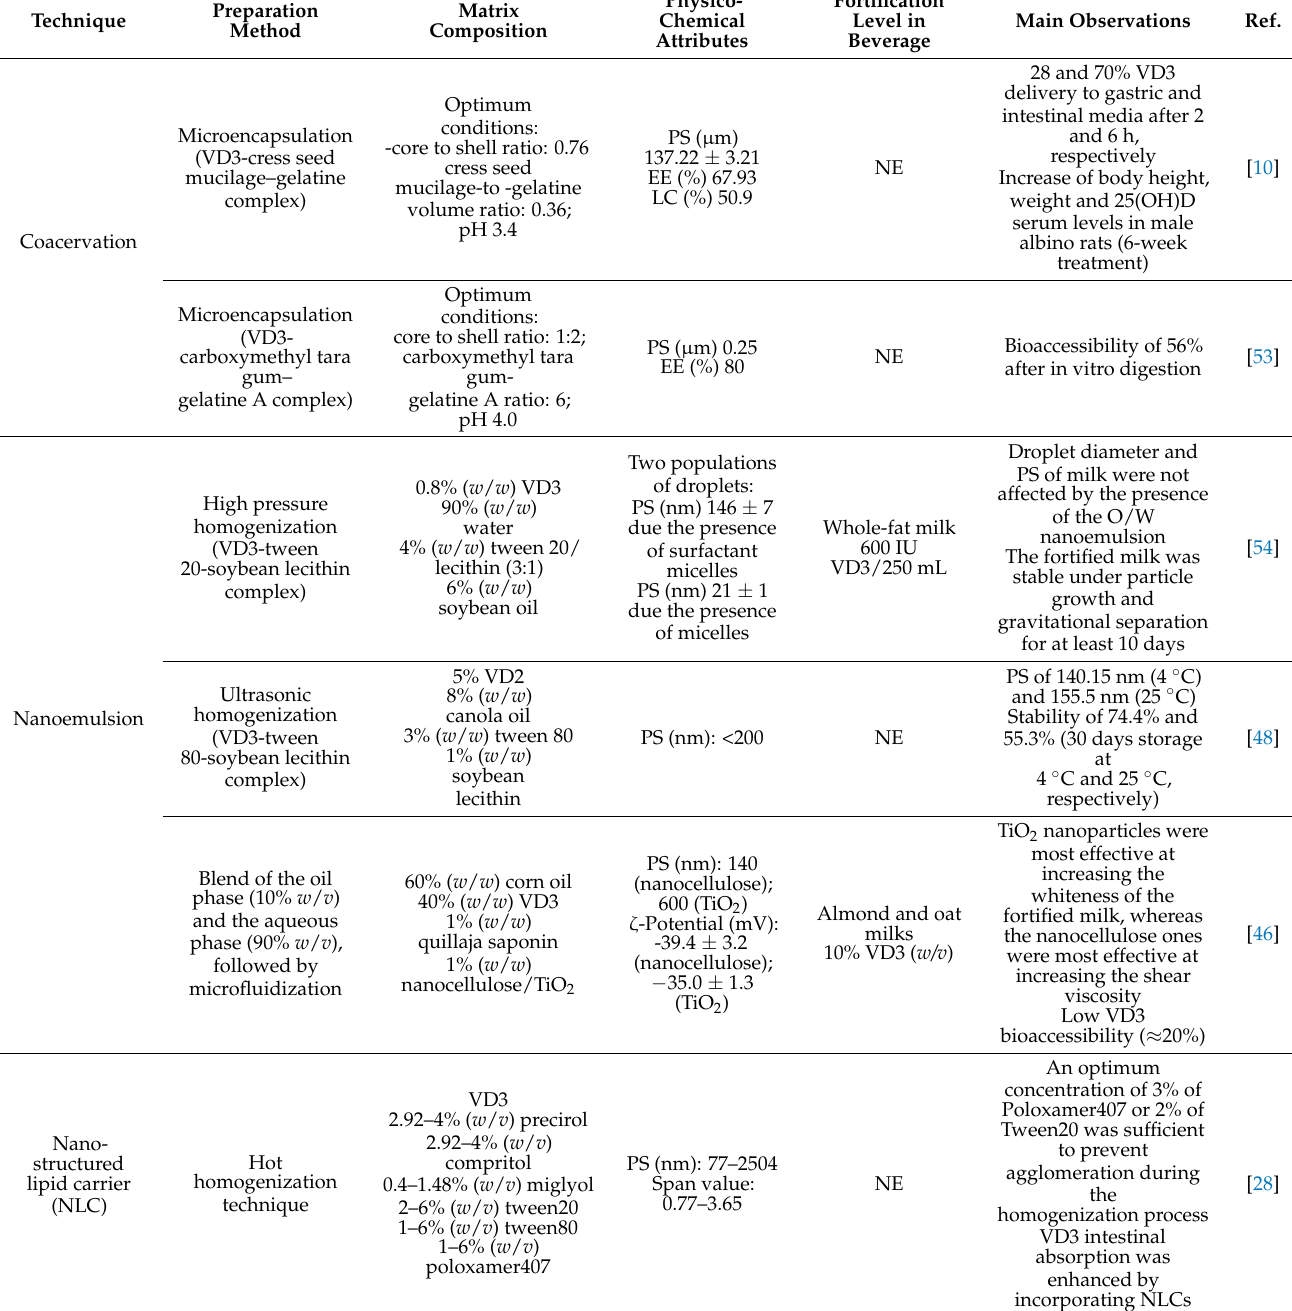
Table 2. Techniques adopted for development of vitamin D-fortified